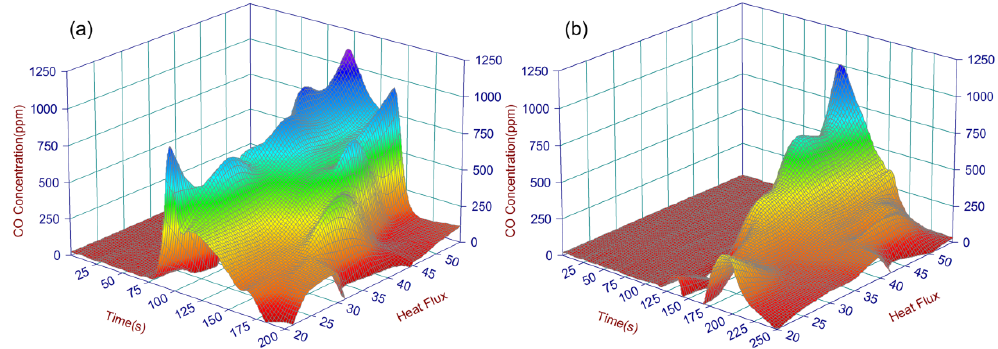
Figure 13. 3D illustrations for CO concentrations of material A ( a ); and B ( b ) in different heat flux.